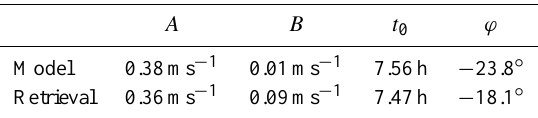
Fig. 9. Radial velocities measured by the HF radar station at the island Wangerooge on 1 November 2009 at 01:00UTC (top). Cor- responding 2D surface current field obtained with the numerical model (bottom). Table 2. Tidal ellipses parameters derived from the numerical model and the respective analysis using HF radar data from a single antenna